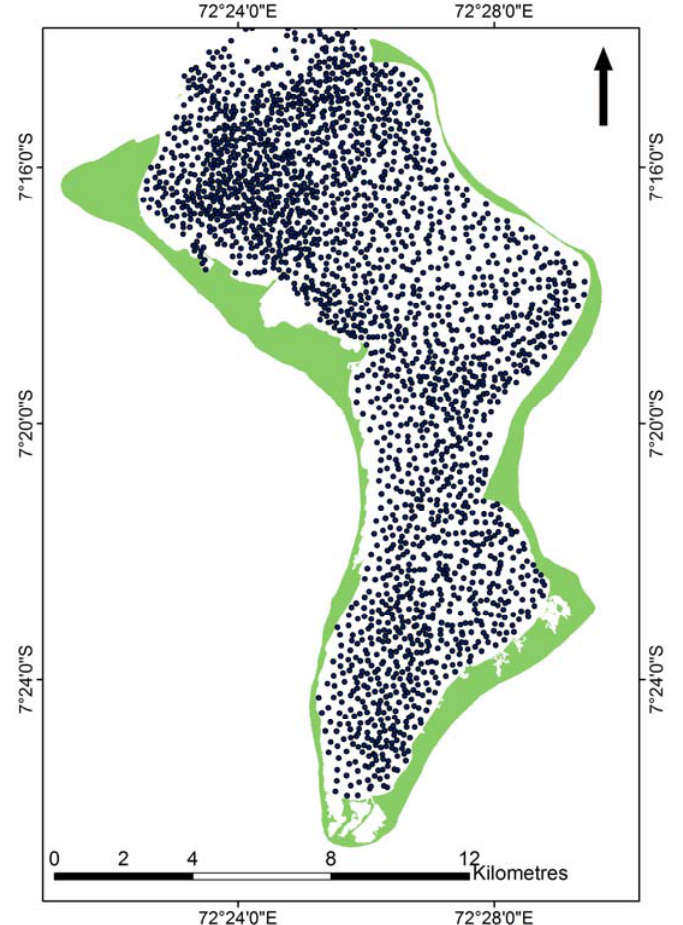
Figure 3. Point file displaying the 3,584 soundings from the 1998 UK Hydrographic Office bathymetric